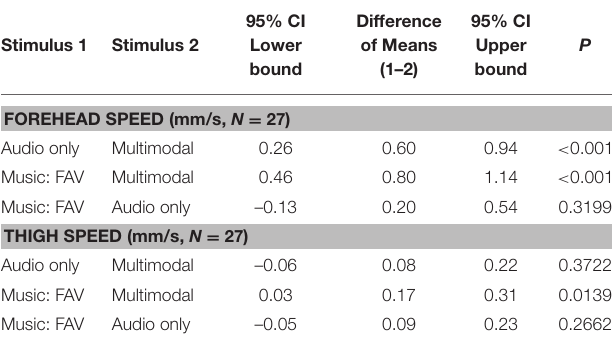
TABLE 6 | Comparison of mean speed of movement elicited by each category of musical